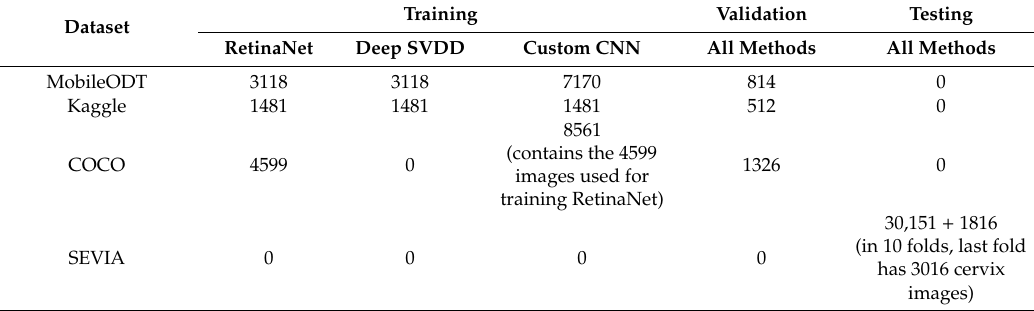
Figure 2. Examples of cervix images used in this study, showing quality variability. 1st row: MobileODT dataset; 2nd row: Kaggle dataset; 3rd row: COCO dataset; 4th row: SEVIA dataset (only the first two images are cervix images, the rest images in this row are non-cervix image samples in this dataset). Table 1. Summary of data split and quantitative details of images used from each